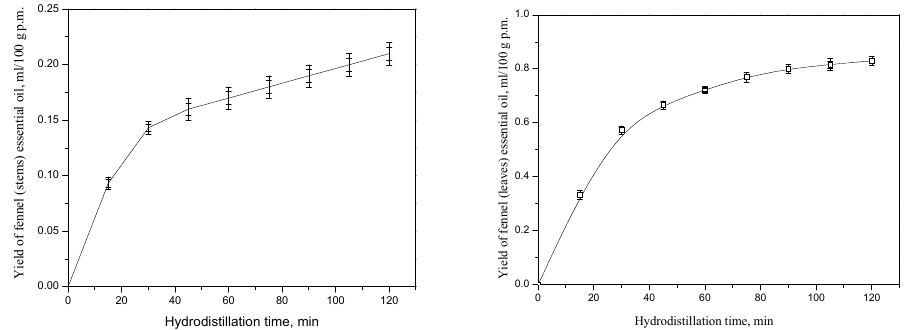
Figure 1. The dependence of the yield of wild fennel stems and leaves essential oil from the hydrodistillation time.